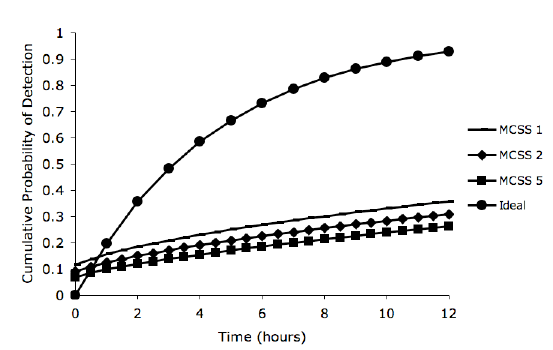
Fig.12. Average CPD of Final USDEA Mesh Fields Communications Range = 5.5